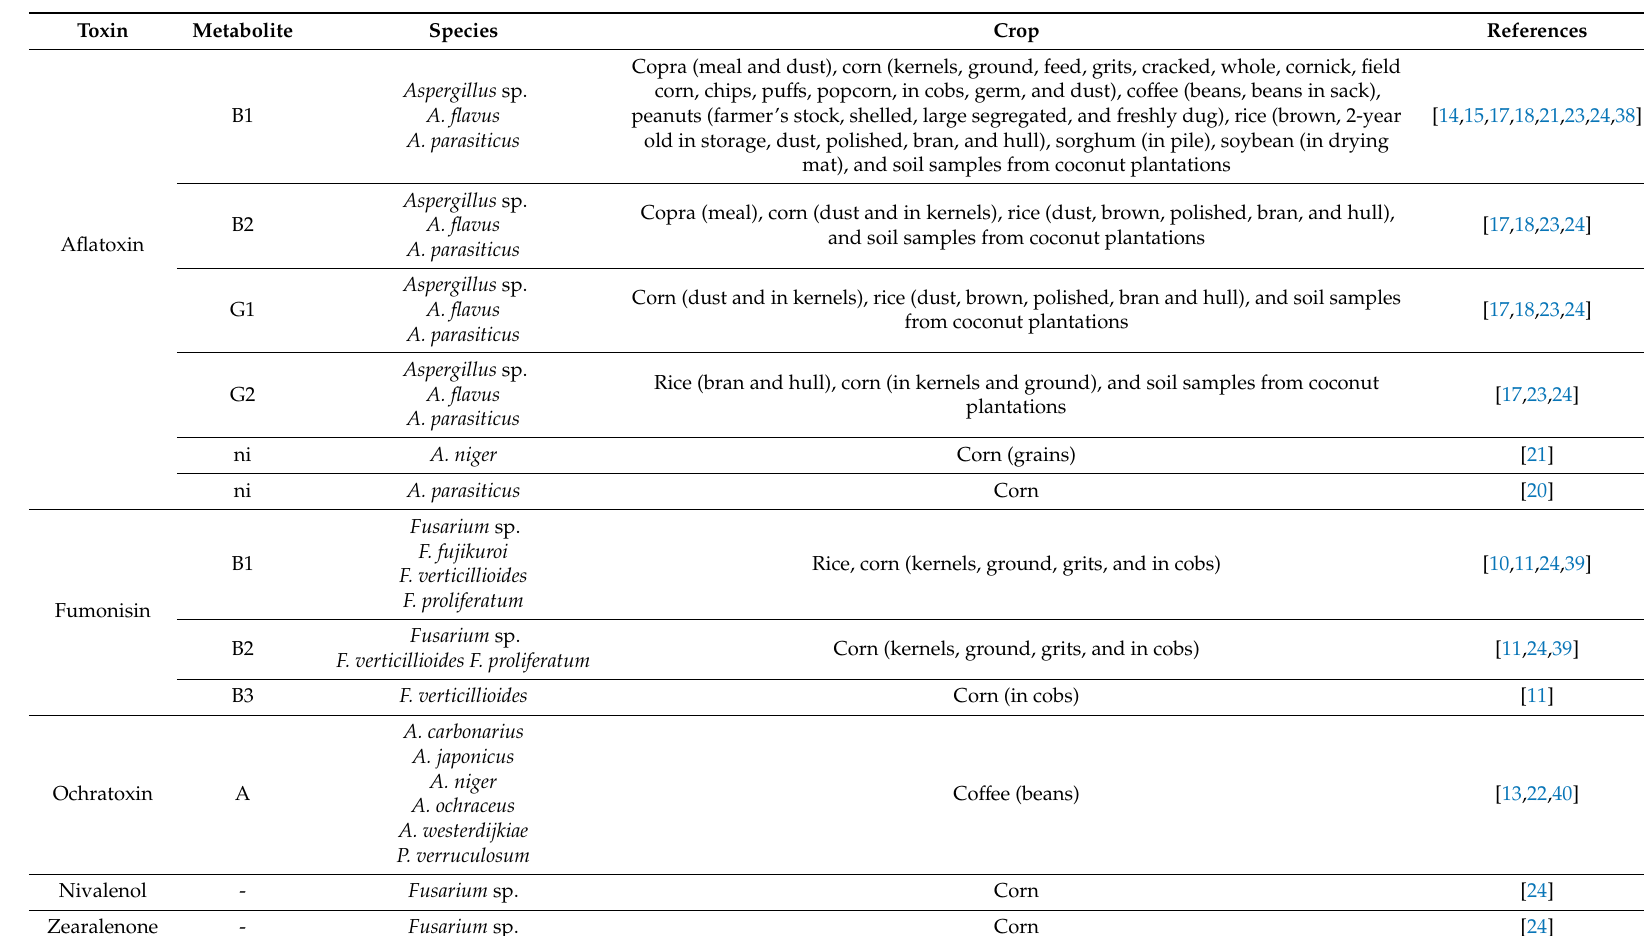
Table 2. Mycotoxins, and their associated mycotoxigenic fungi, detected in agricultural crop commodities in the